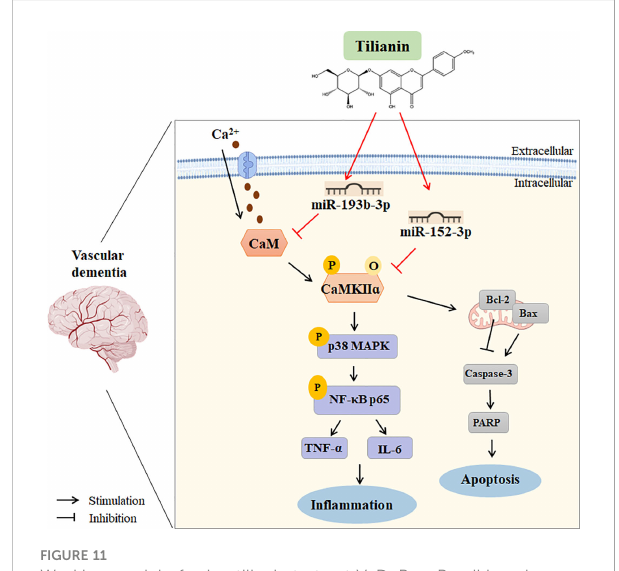
FIGURE 11 Working model of using tilianin to treat VaD. Bax: B cell lymphoma- 2 associated X protein; Bcl-2: B cell lymphoma-2; CaM: calmodulin; CaMKII: Ca 2+ /calmodulin-dependent protein kinase II; Caspase-3: cysteine-dependent aspartate-speci fi c proteases-3; IL-6: interleukin-6; NF- k B: nuclear factor kappa-B; TNF- a : tumor necrosis